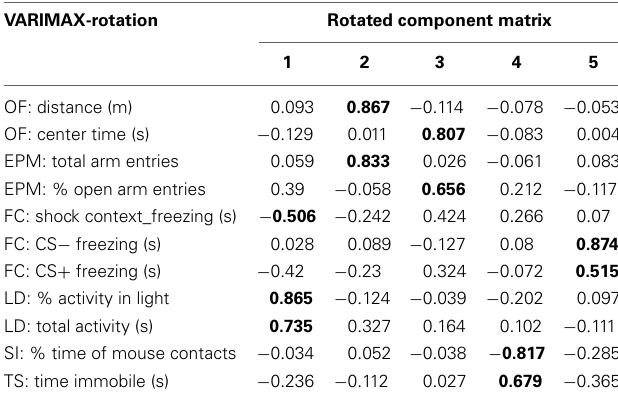
Table 1 | Factor loadings of the analyzed parameters for every factor extracted by factor